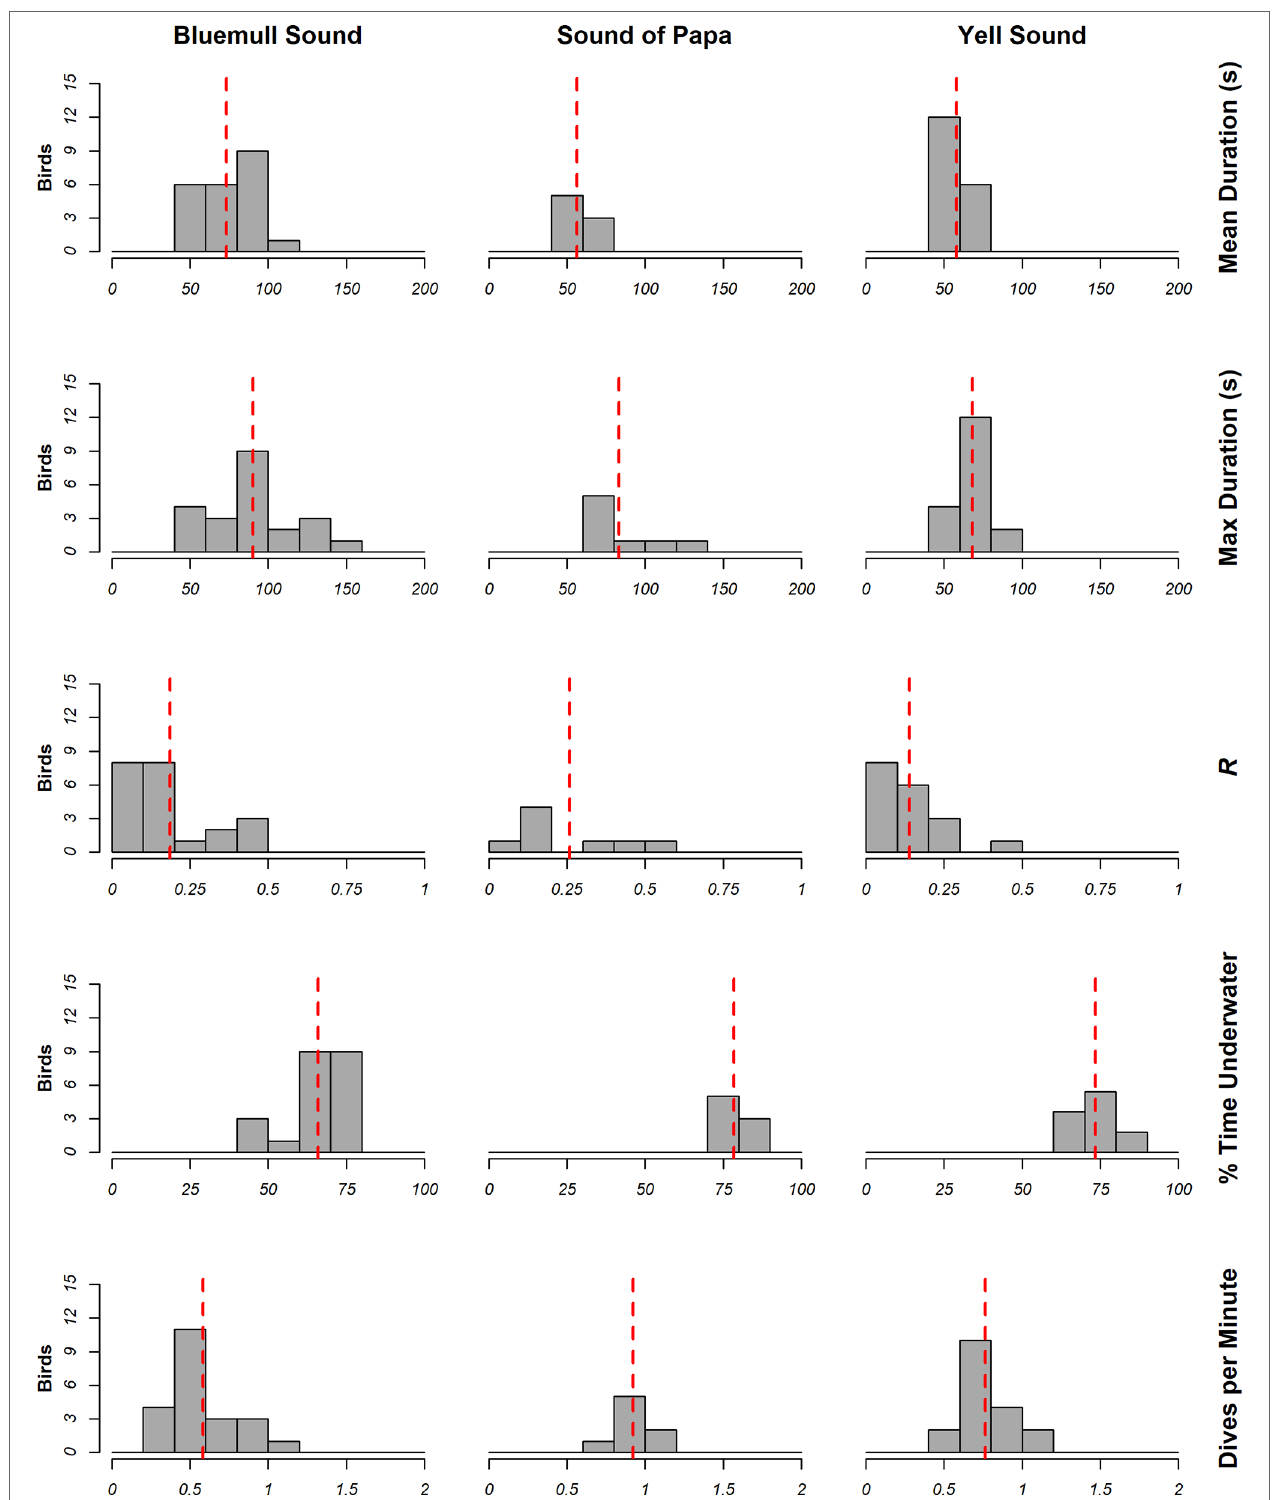
FIGURE 7 | Summary of dive metrics calculated from measurements of animal behavior at Bluemull Sound (n=22), Sound of Papa (n=8) and Yell Sound (n=18). The red line illustrates the mean measurement at the study